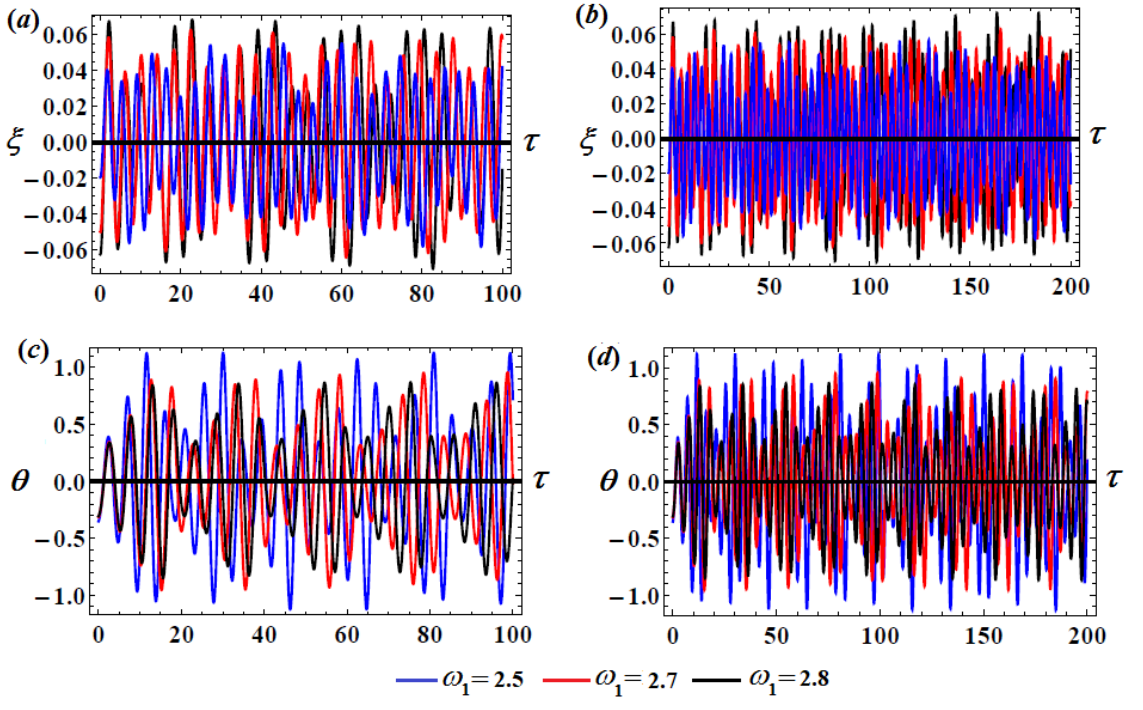
1 1 (= 2.5, 2.7, 2.8) , = 2.1 s s   − − and Figure 2. Time history portraits of ξ and θ when ω 1 (= 2.5,2.7,2.8 ) s − 1 , ω 2 = 2.1 s − 1 and c 1 = 0.02, c 2 = 0.03 m − 2 : 1 2